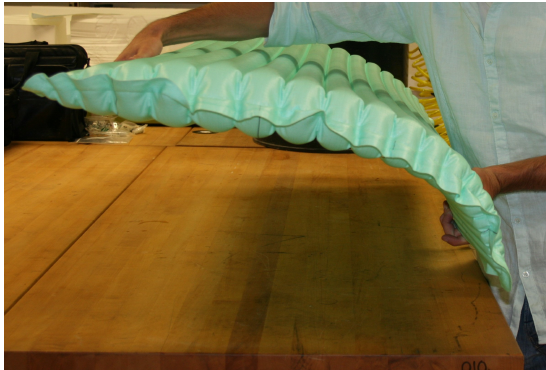
Figure 18. High flexibility in the chordwise direction of the woven